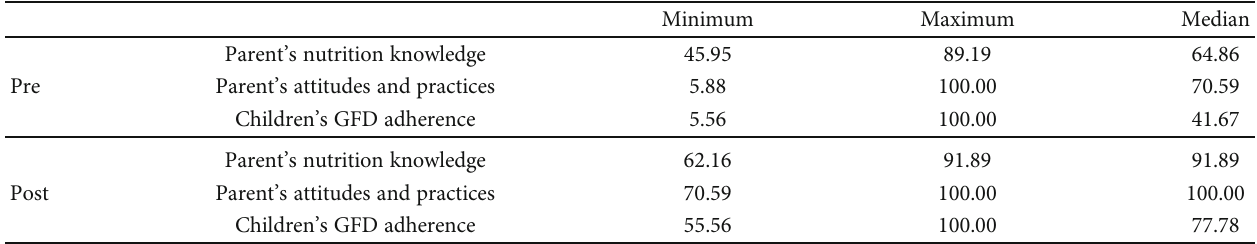
Table 5: Parent ’ s KAP and patient ’ s adherence pre- and post intervention ( n = 40 ).